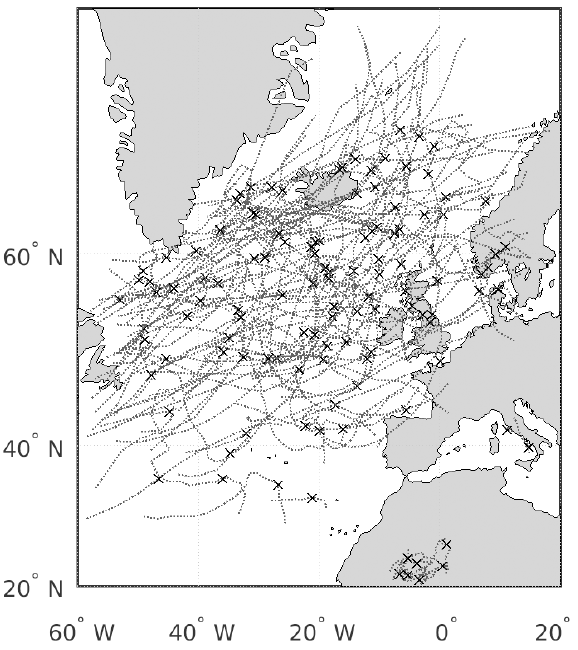
Figure 1. Mercator projection of the area covered, with all 139 cy- clone tracks found by the algorithm. Crosses indicate the location of minimum sea level pressure along each